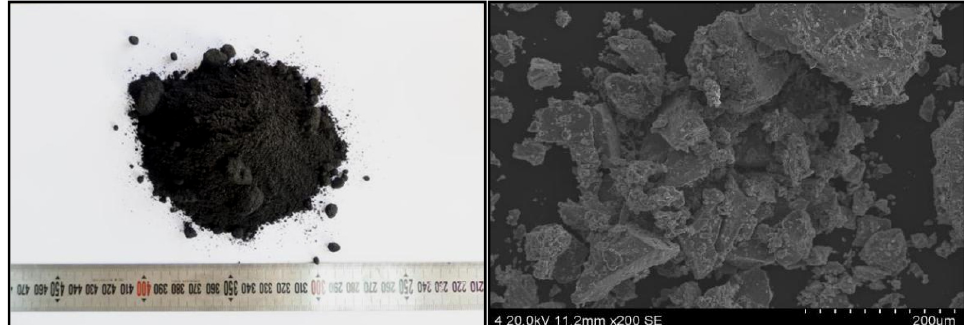
Figure 1. XRD pattern of RVT ore.